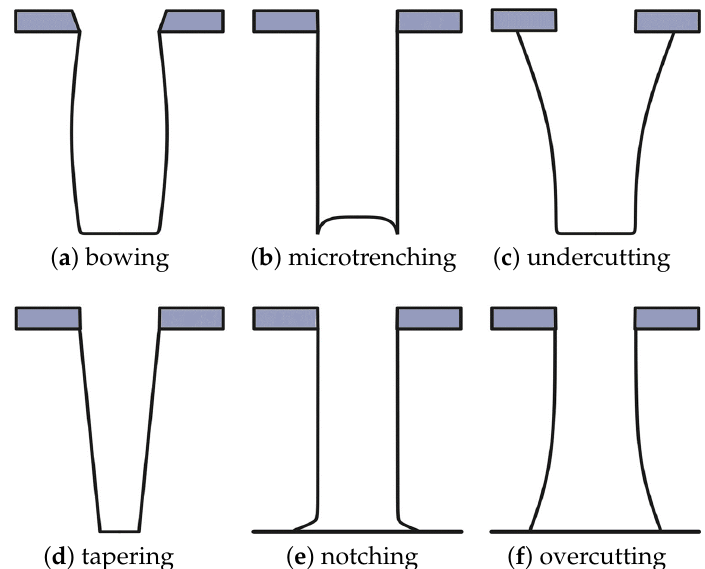
Figure 5. Effects of plasma etching on the final profile: ( a ) bowing due to mask faceting; ( b ) mi- crotrenching due to an enhanced ion flux along the sidewall; ( c ) undercutting due to an isotropic component in the etch process; ( d ) sidewall tapering due to sidewall inhibition or deposition of polymer on the sidewall; ( e ) notching at the interface with an etch-stop layer due to inadequate side- wall passivation or charging effects; ( f ) Re-entrant profile (overcutting) due to inadequate sidewall passivation and/or ion scattering. (Reprinted with permission from Donnelly and Kornblit[38]). Table 1. Parameters used for the mask study, which correspond to a chamber with a total gas flow rate of 80sccm at a pressure of 25mTorr, an inductive coil power of 800W, and an RF-bias voltage of − 120V at a wafer temperature of 5 °C. The gas flow rates of the individual gases were 40sccm SF and 40sccm O 2 , as described